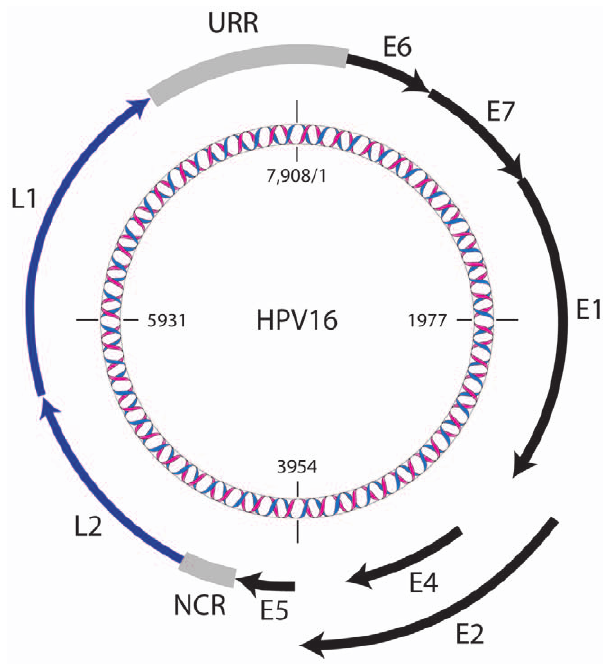
Figure 1. A schematic representation of the HPV16 genome. The 7,908 bp circular, double-stranded DNA genome of the HPV16 reference sequence is illustrated. Genes expressed early in the viral life cycle (early genes) are drawn with solid black lines and their names prefixed by an ‘‘E’’. Genes expressed late in the viral life cycle (late genes) that encode the structural capsid proteins, are indicated by blue lines and have names prefixed by an ‘‘L’’. The upstream regulatory region (URR) and a second non-coding region (NCR) are drawn in gray. The viral genome and positions within the DNA sequence are displayed by the helix and numbers,